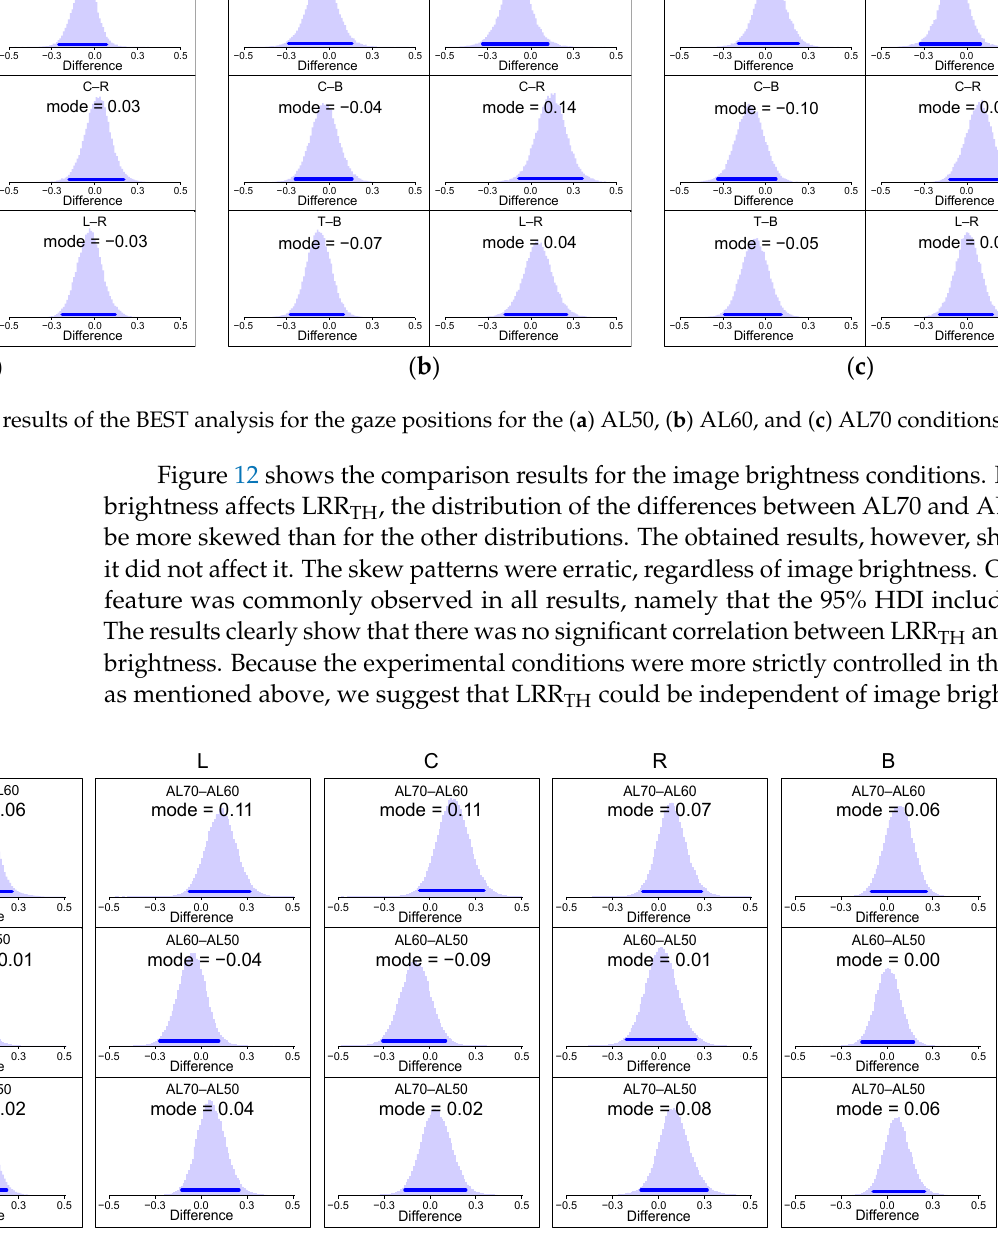
Figure 12. The results of the BEST analysis for the image brightness conditions. 3.3. Performance Evaluation for Power-Saving The total dissipated power (TDP) of the OLED display is given by [35].